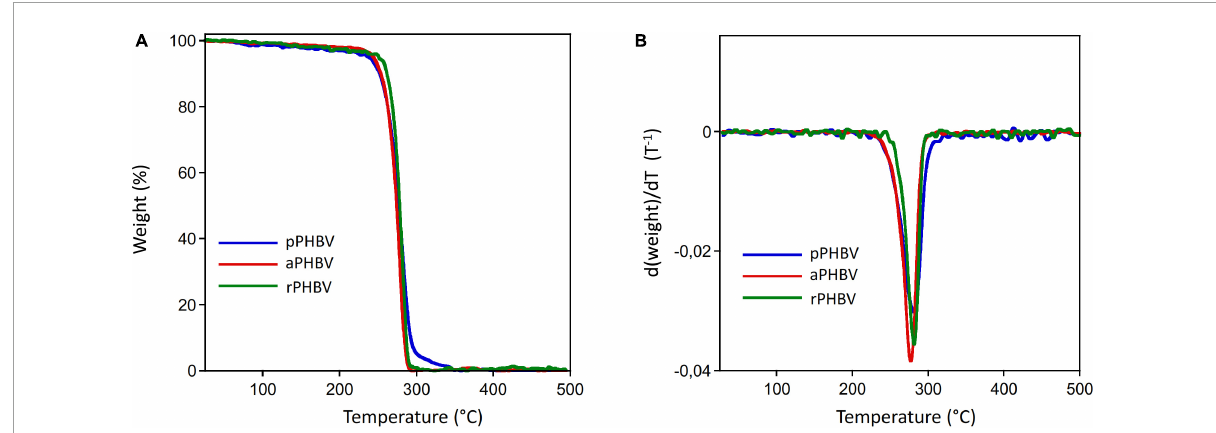
FIGURE5 Thermogravimetric analysis curves of PHBV produced in the wasted bread/seawater substrate: pPHBV, obtained from the CHCl 3 :H 2 O separation and the precipitation with cold ethanol; rPHBV, obtained by the replacement of the CHCl 3 :H 2 O separation with repeated washing with water; aPHBV, obtained by the replacement of the CHCl 3 :H 2 O separation with repeated washing with water, followed by purification with cold ethanol. (A) Weight curve, (B) weight derivative as function of temperature.